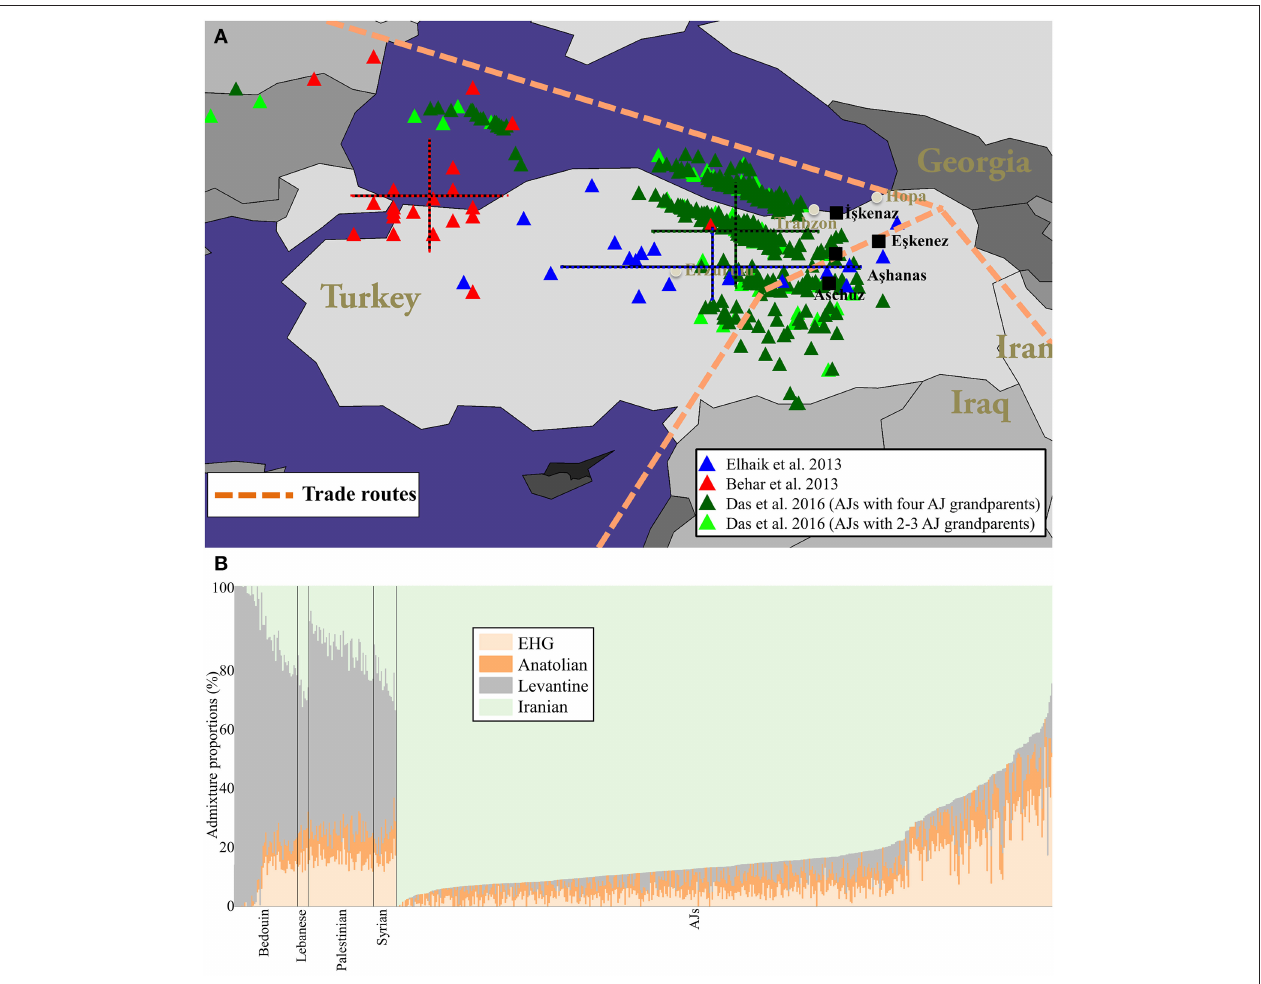
FIGURE 1 | The localization of AJs and their ancient admixture proportions compared to neighboring populations. (A) Geographical predictions of individuals analyzed in three separate studies employing different tools: Elhaik (2013, Figure 4) (blue), Behar et al. (2013, Figure 2B) (red), and Das et al. (2016, Figure 4) (dark green for AJs who have four AJ grandparents and light green for the rest) are shown. Color matching mean and standard deviation (bars) of the longitude and latitude are shown for each cohort. Since we were unsuccessful in obtaining the data points of Behar et al. (2013, Figure 2B) from the corresponding author, we procured 78% of the data points from their figure. Due to the low quality of their figure we were unable to reliably extract the remaining data points. (B) Supervised ADMIXTURE results. For brevity, subpopulations were collapsed. The x axis represents individuals. Each individual is represented by a vertical stacked column of color-coded admixture proportions that reflect genetic contributions from ancient Hunter-Gatherer, Anatolian, Levantine, and Iranian